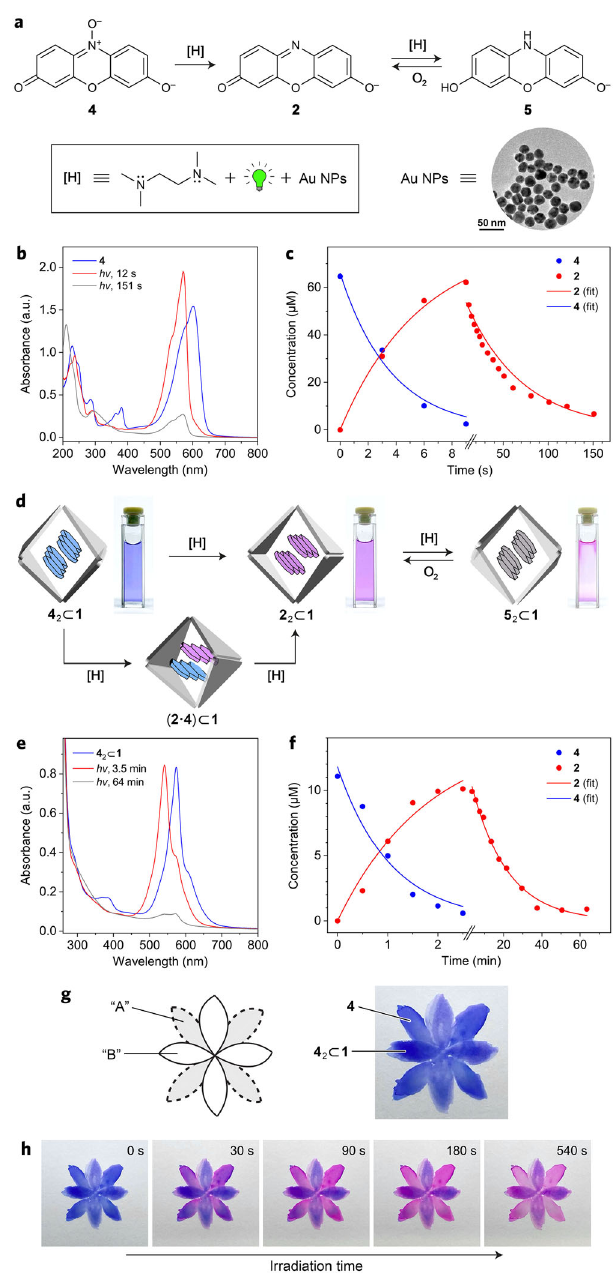
Fig. 6 Modulating the reactivity of resazurin and resoru fi n